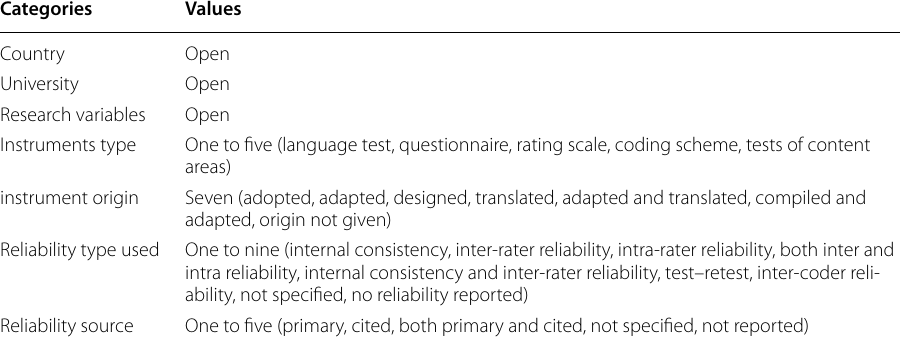
Table 1 The final coding scheme